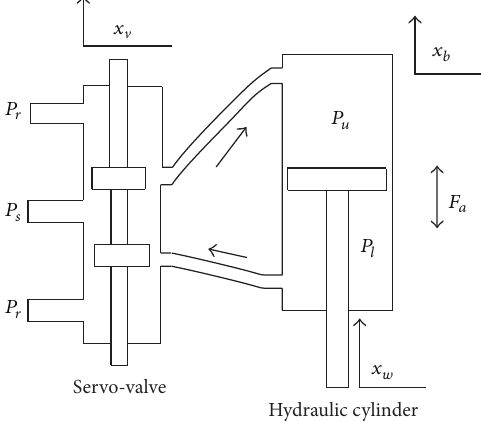
Figure 2: The electrohydraulic actuator